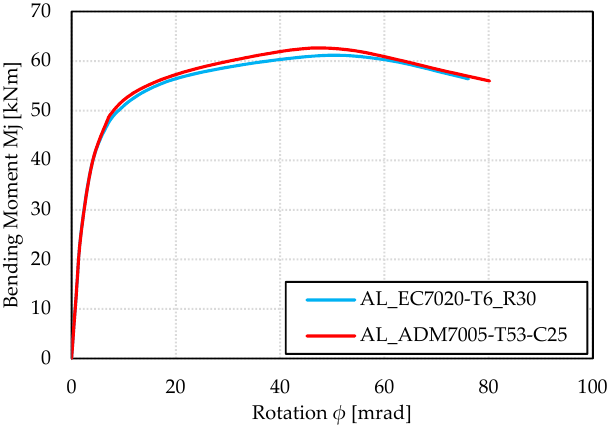
Figure 13. Moment–rotation curves for models with aluminium alloys EN AW-7xxx-Txx.